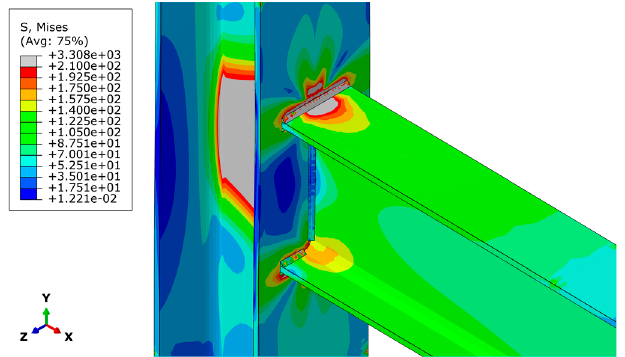
Figure 10. Failure of the weld for the aluminium beam-to-column joint (AL_T6082-T6_C25).